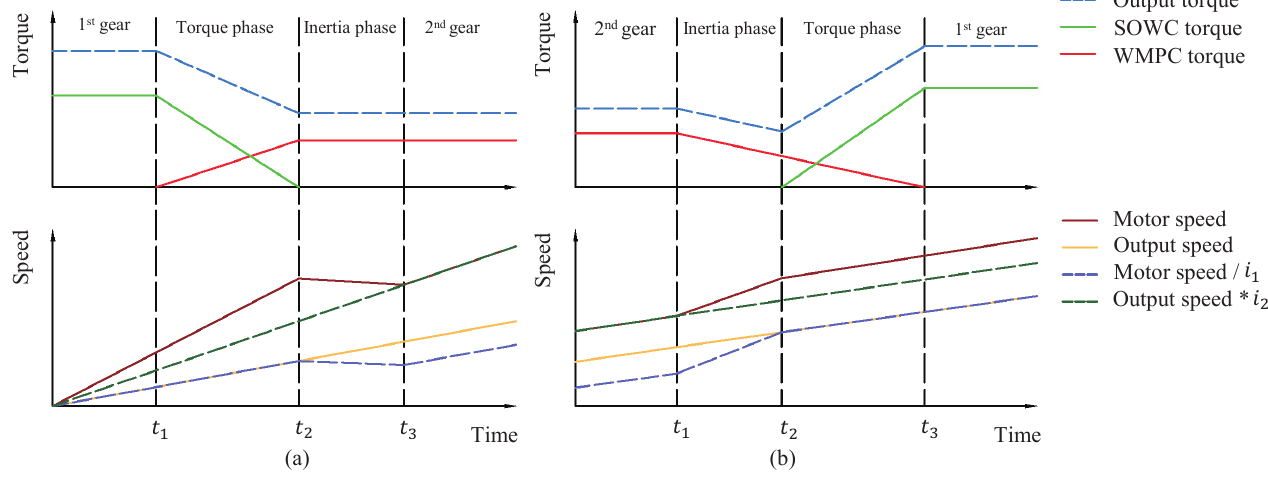
Figure 9. Ideal shifting process of IW-AMT: ( a ) Upshifting process. ( b ) Downshifting